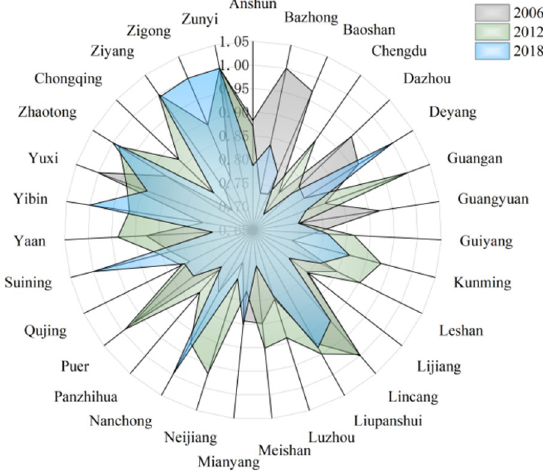
Fig 5. Technology gap rate of cities in the upper